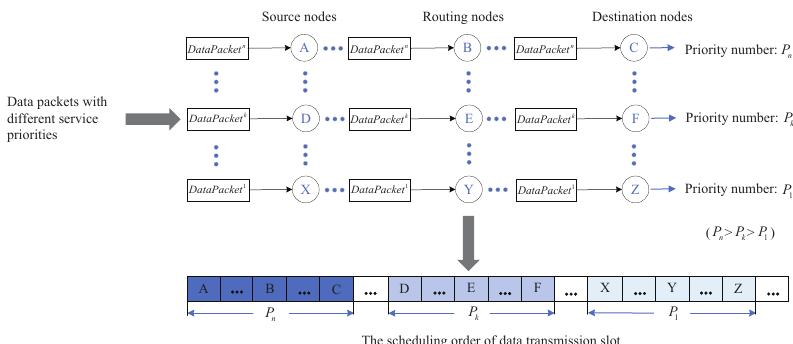
Figure 6. Transmission paths of different service priority information and data transmission slot allocation order of corresponding